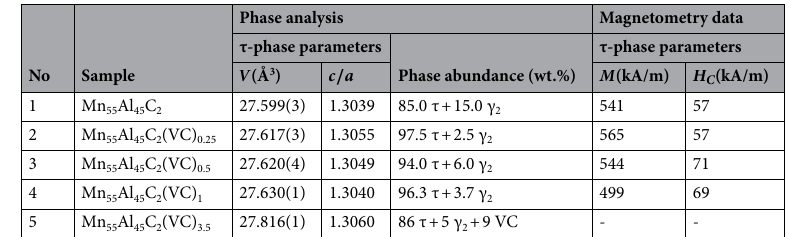
Table 1. Phase analysis, magnetization at 9 T and coercivity values of the studied Mn 55 Al 45 C 2 (VC) x ( x = 0, 0.25, 0.5, 1 and 3.5) alloys. Abbreviations used in the table: τ-Mn 55 Al 45 C 2 and γ 2 -Mn 5 Al 8 .